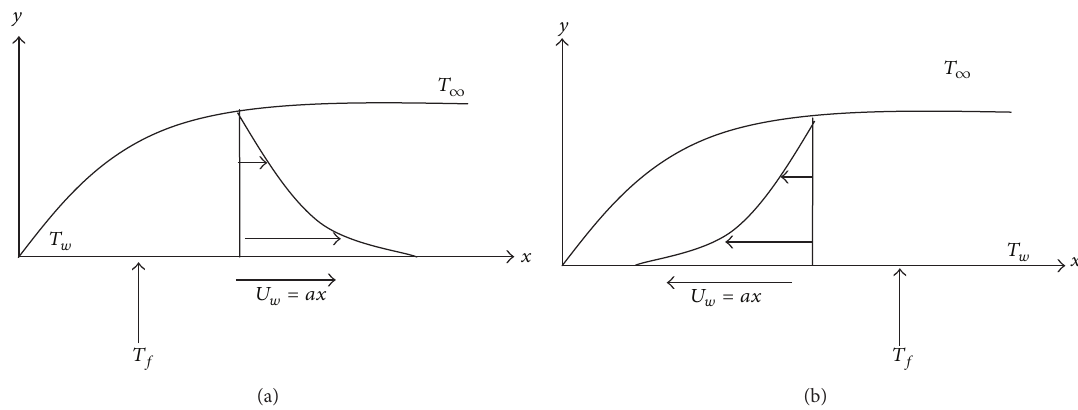
Figure 1: Geometry of the problem for (a) stretching and (b) shrinking